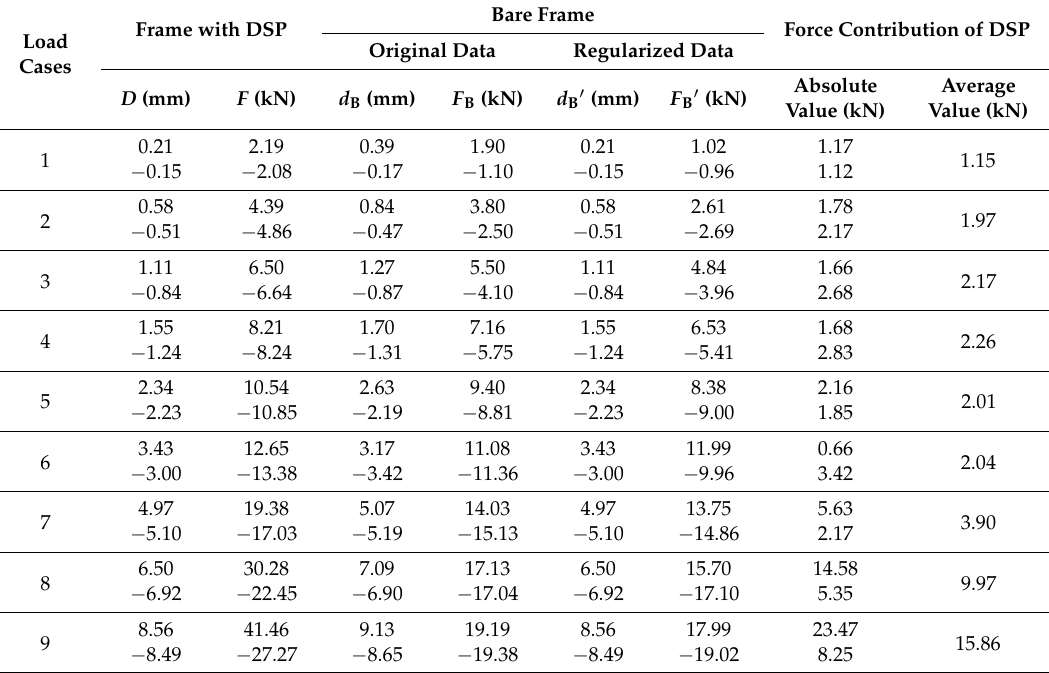
Table 4. Calculation of the force contribution of